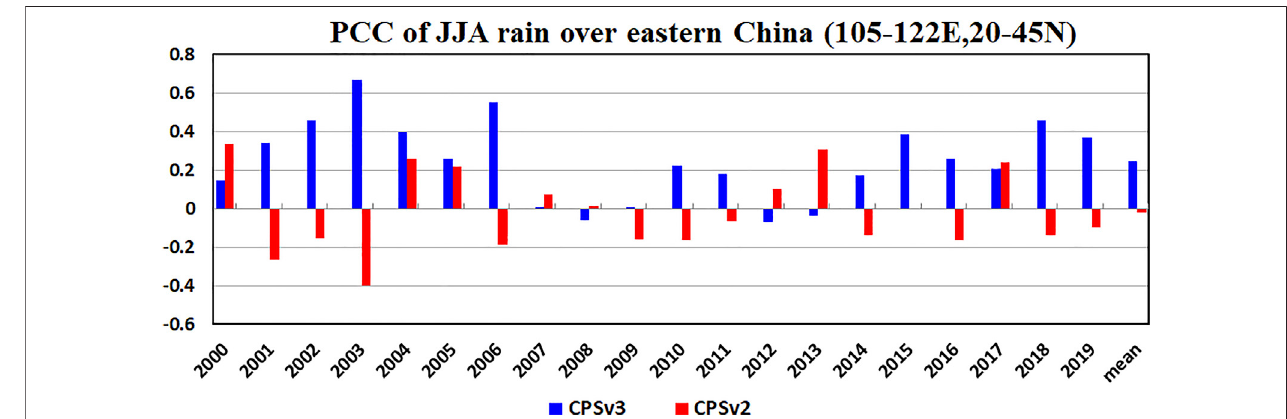
FIGURE7| Patterncorrelationcoef fi cients(PCC)oftheJJArainfallanomalybetweenpredictionsandobservationsovereasternChina(105 ° – 122 ° Eand20 ° – 45 ° N).